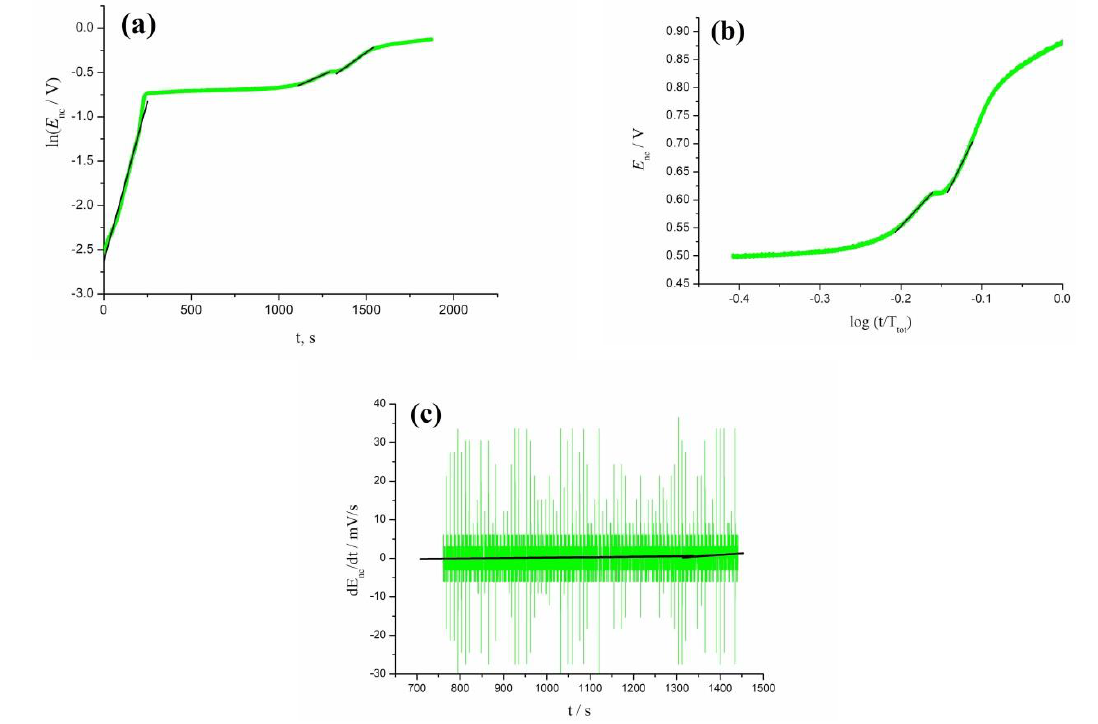
Figure 9. ( a ) Anamorphoses for the transient of the non-current potential, which was recorded from the starting value 0.08 V on Figure 6a in the ln E nc , t scale ( a ) and parts of this transient in E nc , log(t/T tot ) ( b ) and the d E /dt,t ( c )